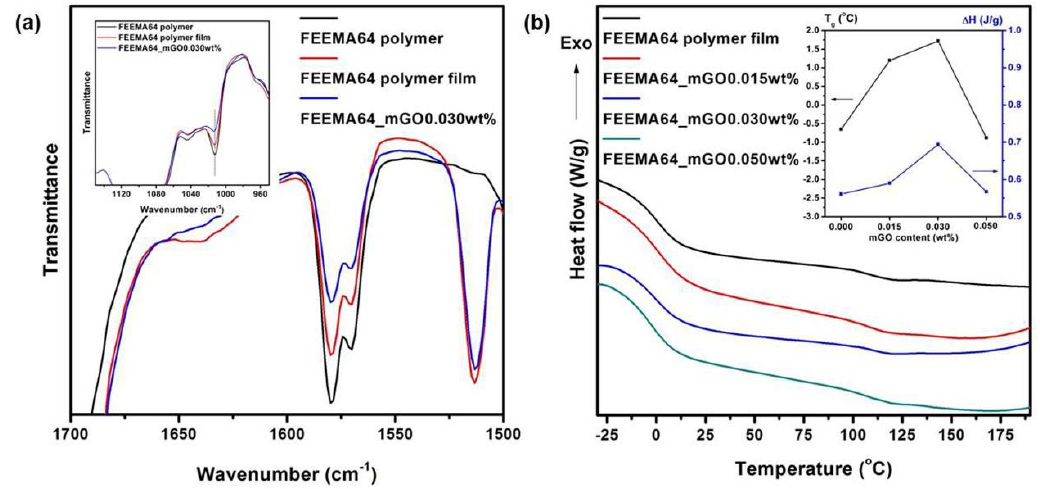
Figure 3. ( a ) FT-IR spectra of FEEMA64 polymer, FEEMA64 polymer film and FEEMA64_mGO0.030 wt%, (inset) furan ring breathing absorption and ( b ) DSC curves of FEEMA64 polymer film